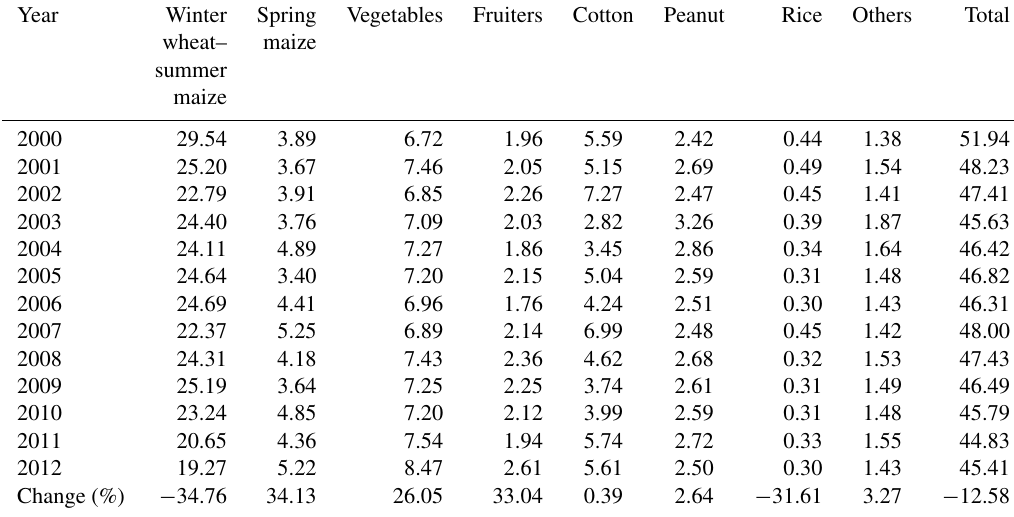
Table 2. Planting areas (10 5 hm 2 ) for the main crops and their percent change. Year